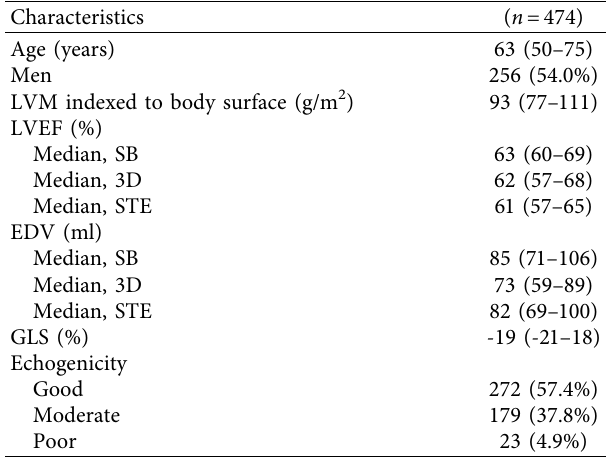
Table 1: Main clinical and echocardiographic characteristics of the patients in this study.